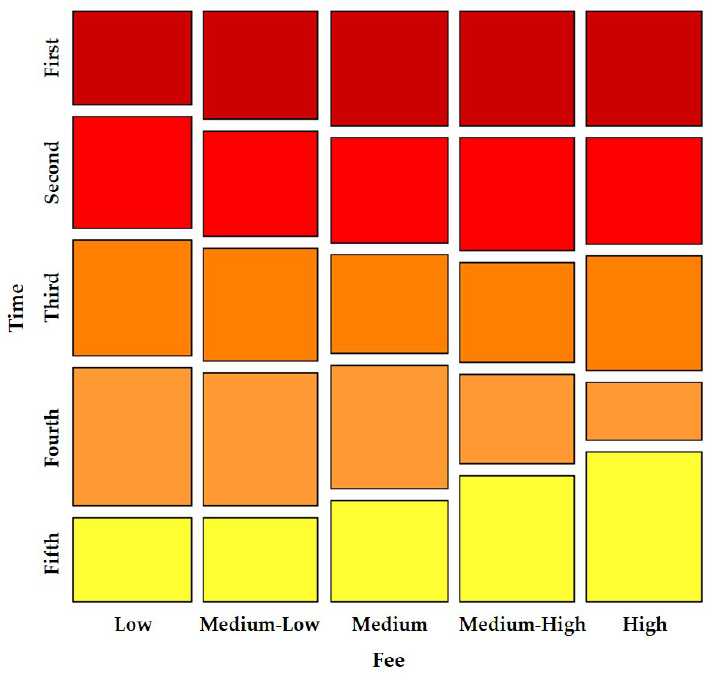
Figure 2. Graphical representation of the probability of executing a SC given the SCs